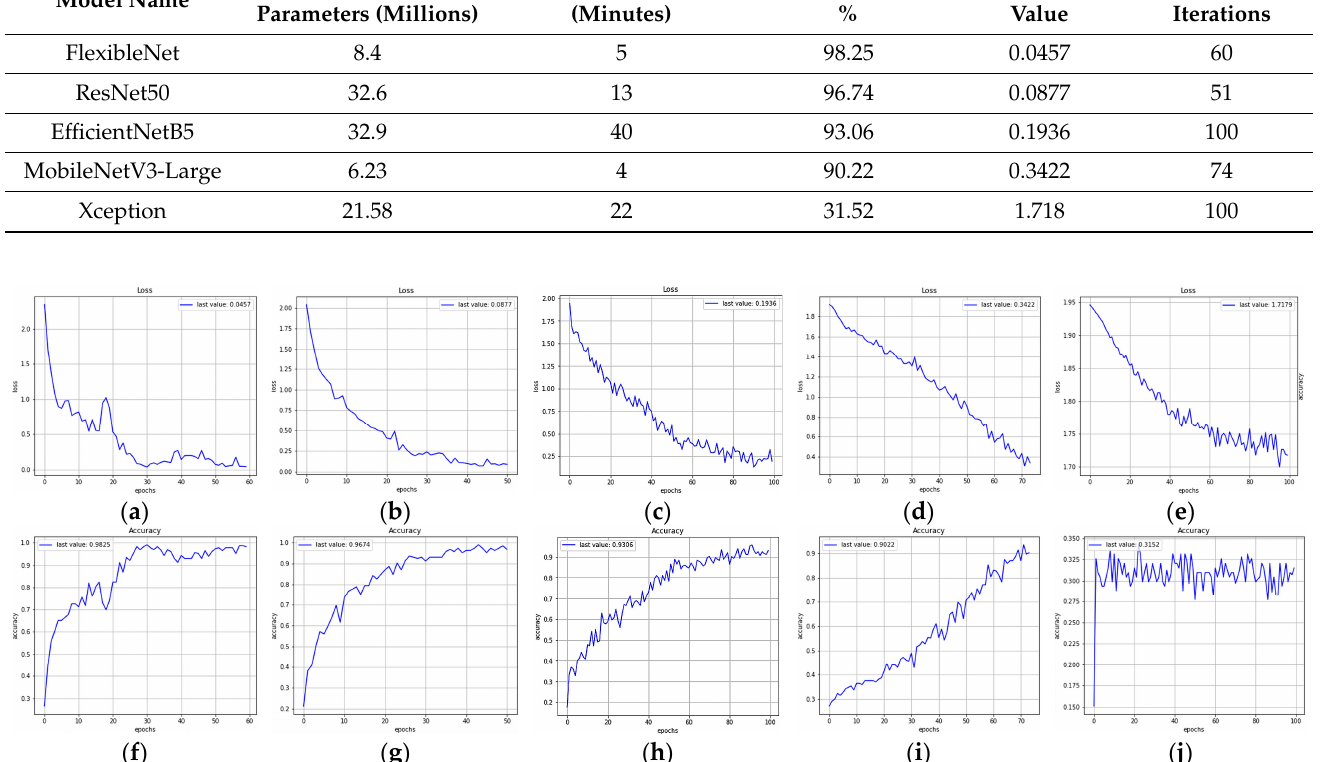
Figure 12. Loss and accuracy of 64 × 64 sub-images processed by ( a , f ) FlexibleNet, ( b , g ) ResNet50, ( c , h ) EfficientNetB5, ( d , i ) MobileNetV3-Large, and ( e , j ) Xception.